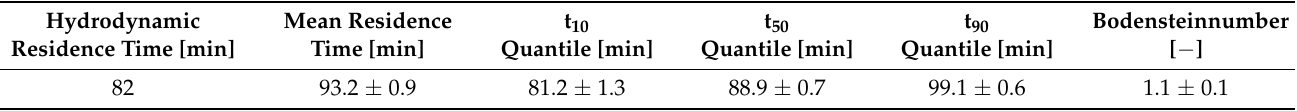
Table 4. Summary of the determined residence time distributions conducted with PVPVA at 165 °C and 15 mg min − 1 with theophylline as a tracer (av ± sd, n = 3).